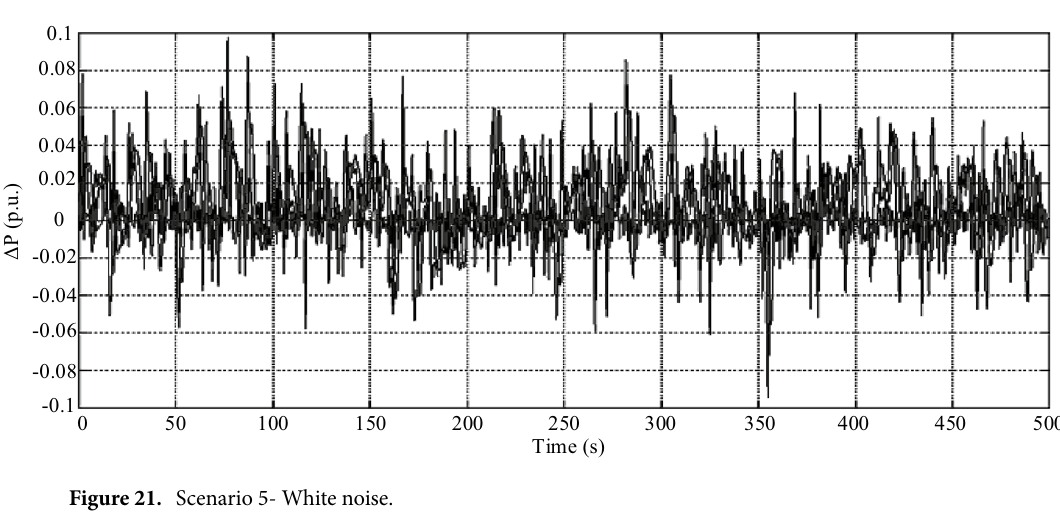
Figure 20. Scenario 4- Microgrid frequency response to solar irradiation, wind speed, and grid load under + 30% uncertainty.